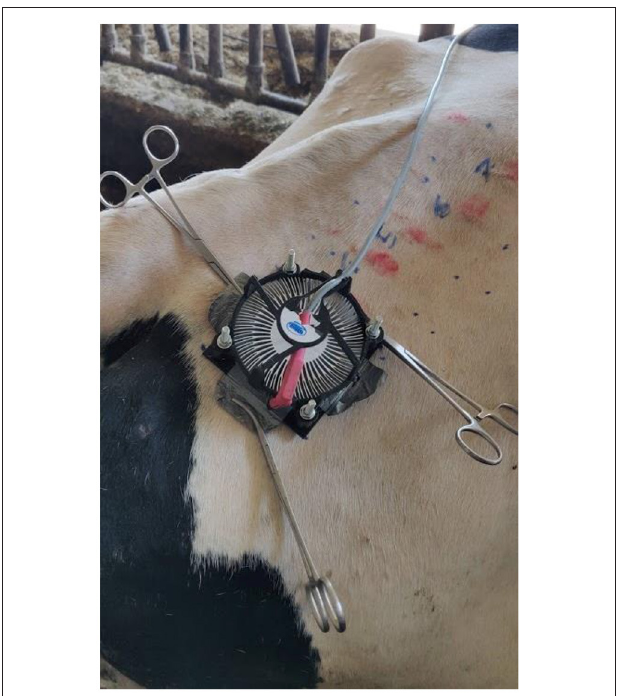
FIGURE 3 | UV light-emitting diode (LED) fixed onto the dorsal pelvis region of cattle with Rochester-Pean forceps.